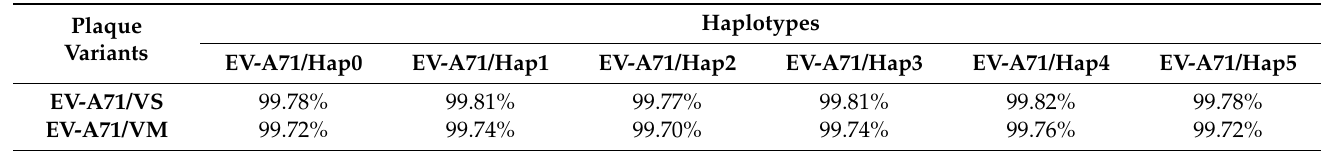
Table 4. Similarity nucleotide sequences of plaque variants EV-A71/VS and EV-A71/VM with all the six